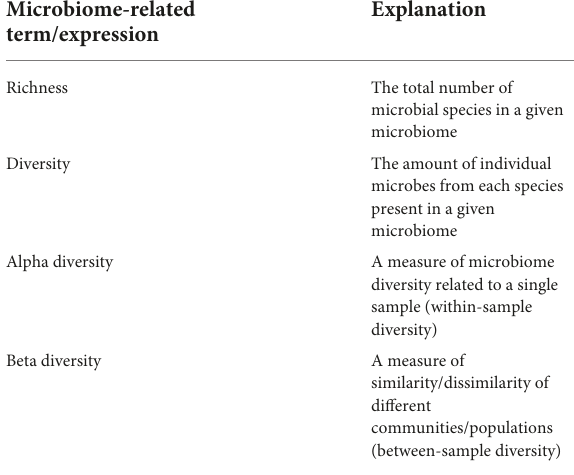
TABLE 1 Microbiome-related